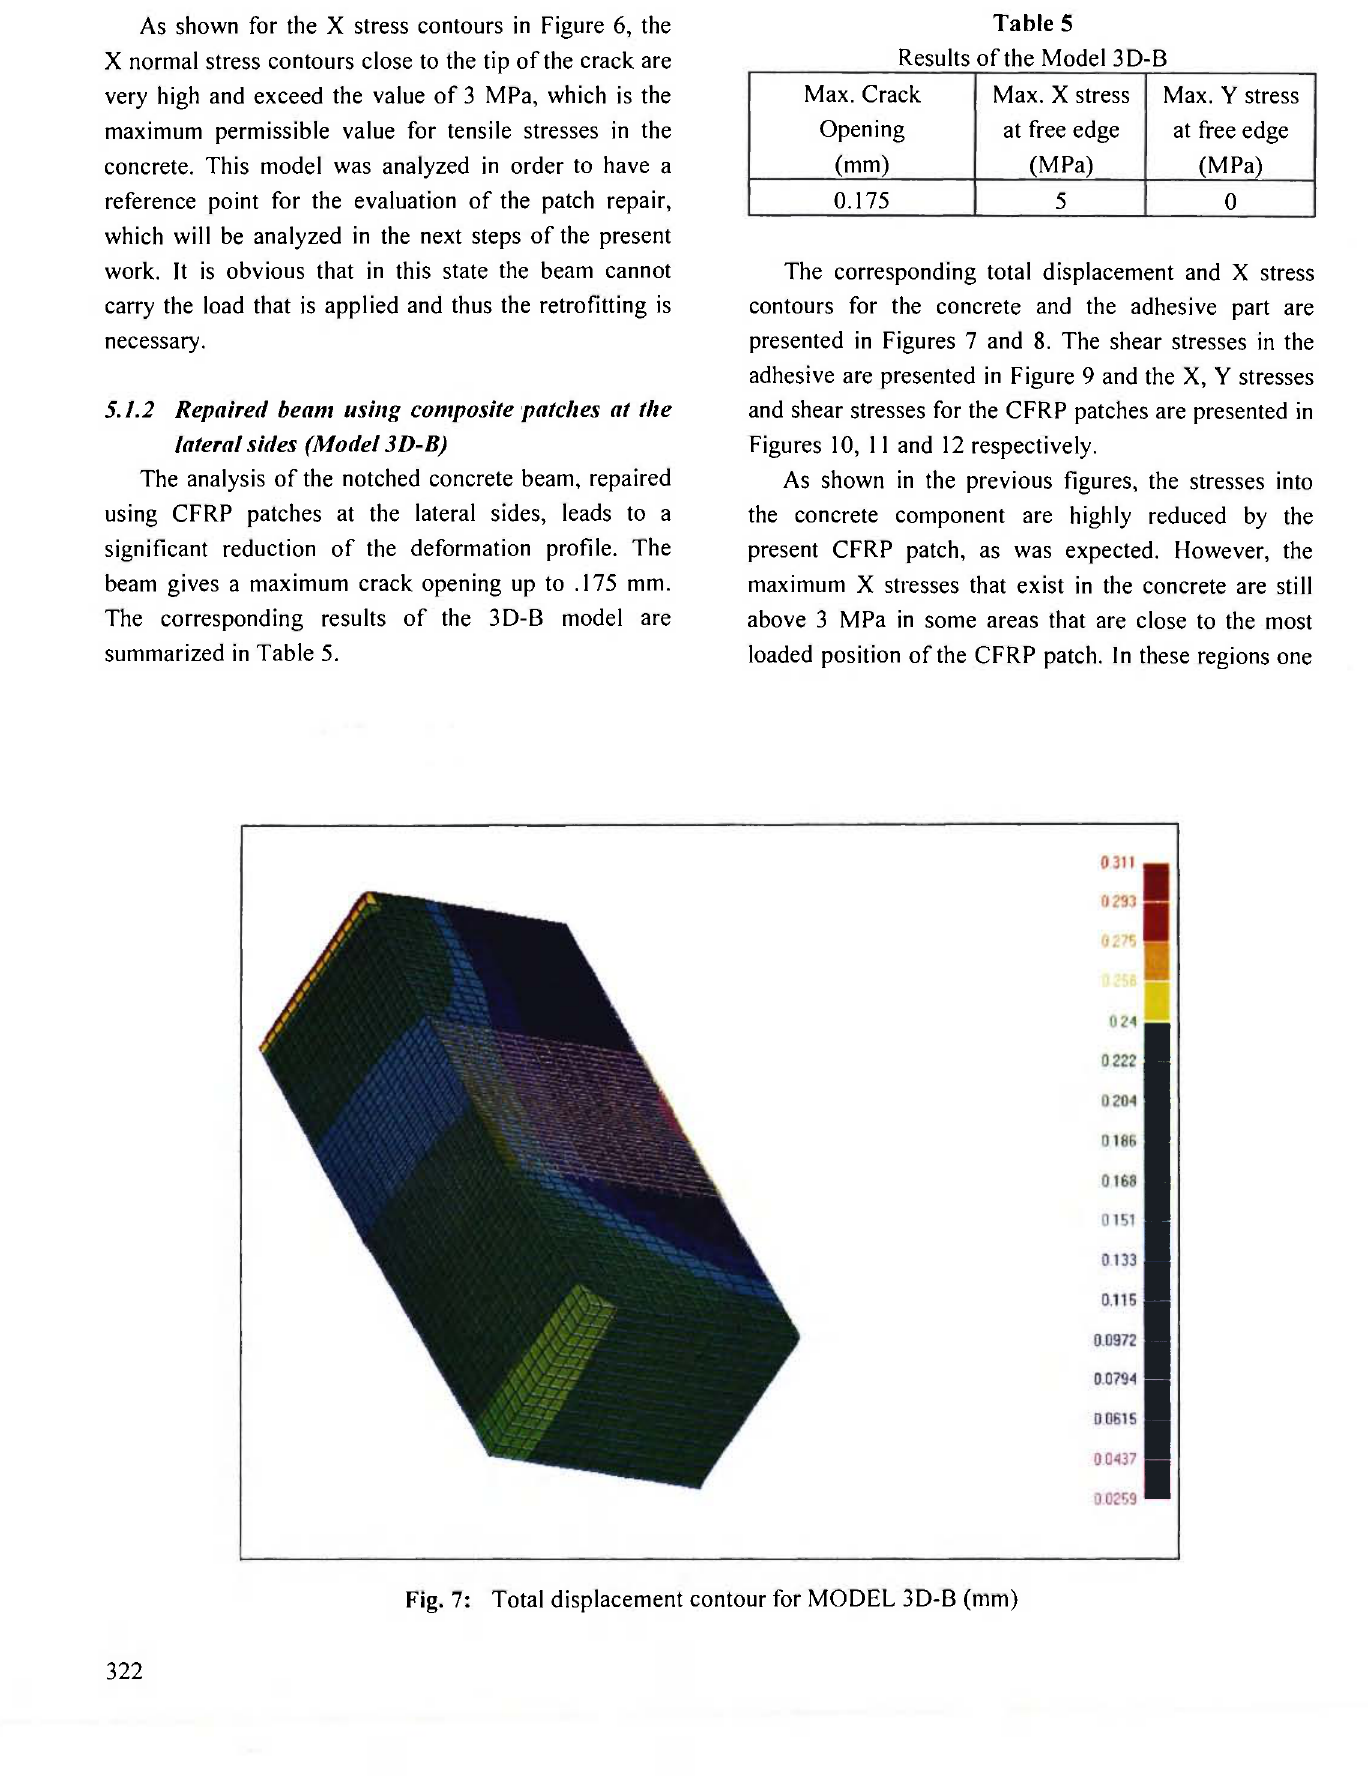
Results of the Model 3 D-B